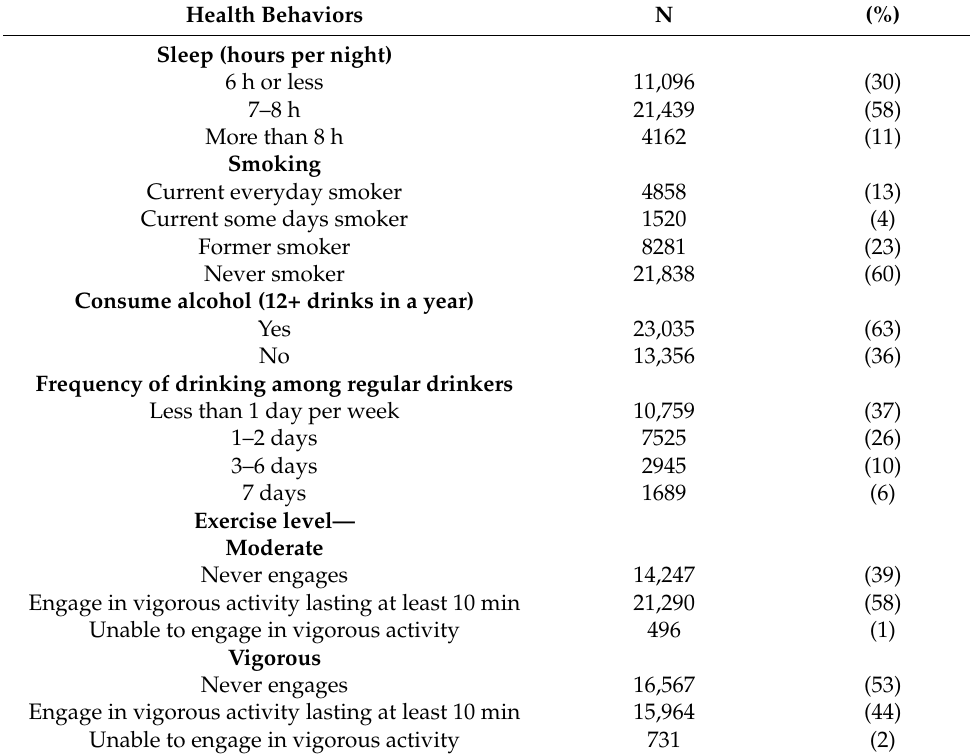
Table 6. Health behaviors of all NHIS respondents: